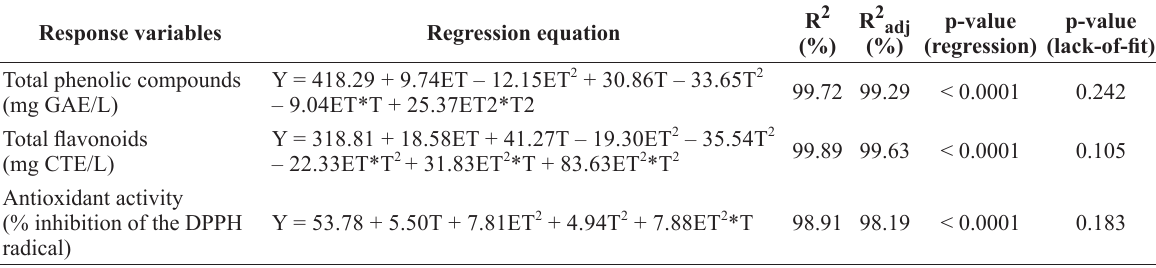
Note: ET = Extraction time (min); T= Temperature